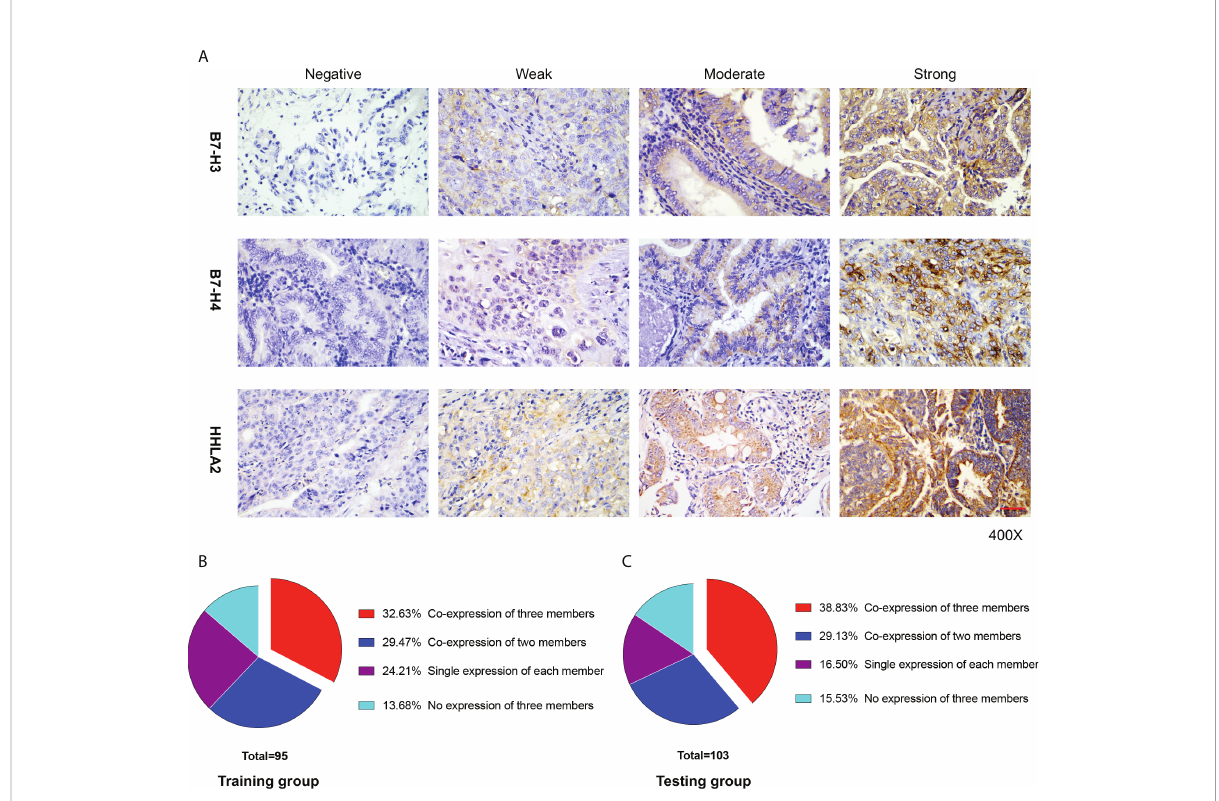
FIGURE 1 B7-H3, B7-H4, and HHLA2 expression in gallbladder (GBC) tissue. (A) Immunohistochemical staining of B7-H3, B7-H4, and HHLA2 in GBC tissues is presented separately. The degree of staining intensity was graded as follows: negative staining, 0; weak staining, 1; moderate staining, 2; and strong staining, 3. Scale bar, 50 m m. (B, C) The proportion of GBC patients in different co-expression patterns of the B7-third group (B7- H3, B7-H4, and HHLA2) in the training and testing groups,